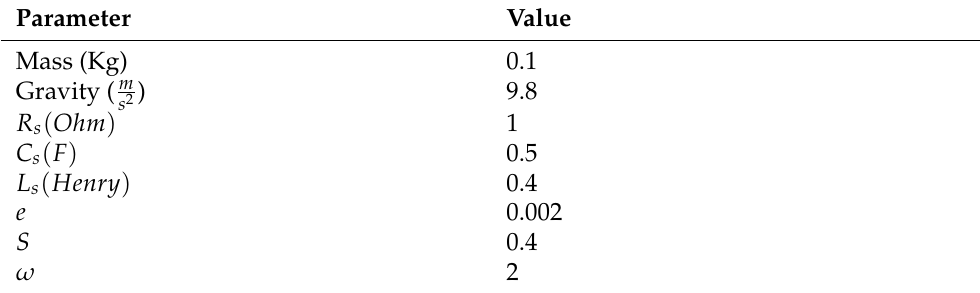
Table 1. Maglev system parameters.